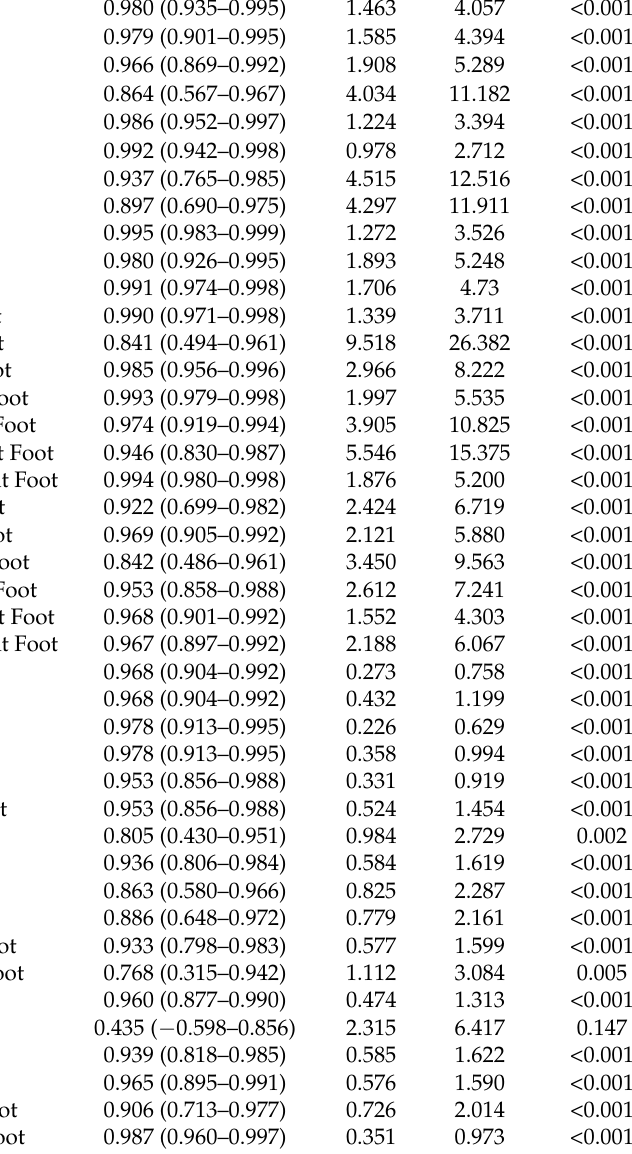
Table 3. Baropodometric platform Intraclass Correlation Coefficients, Standard Error of Measurement and Minimal Detectable Change values performed in right and left foot before riding on a Supersport motorcycle, after riding on a Supersport motorcycle, and after riding with an EVA insole on a Supersport